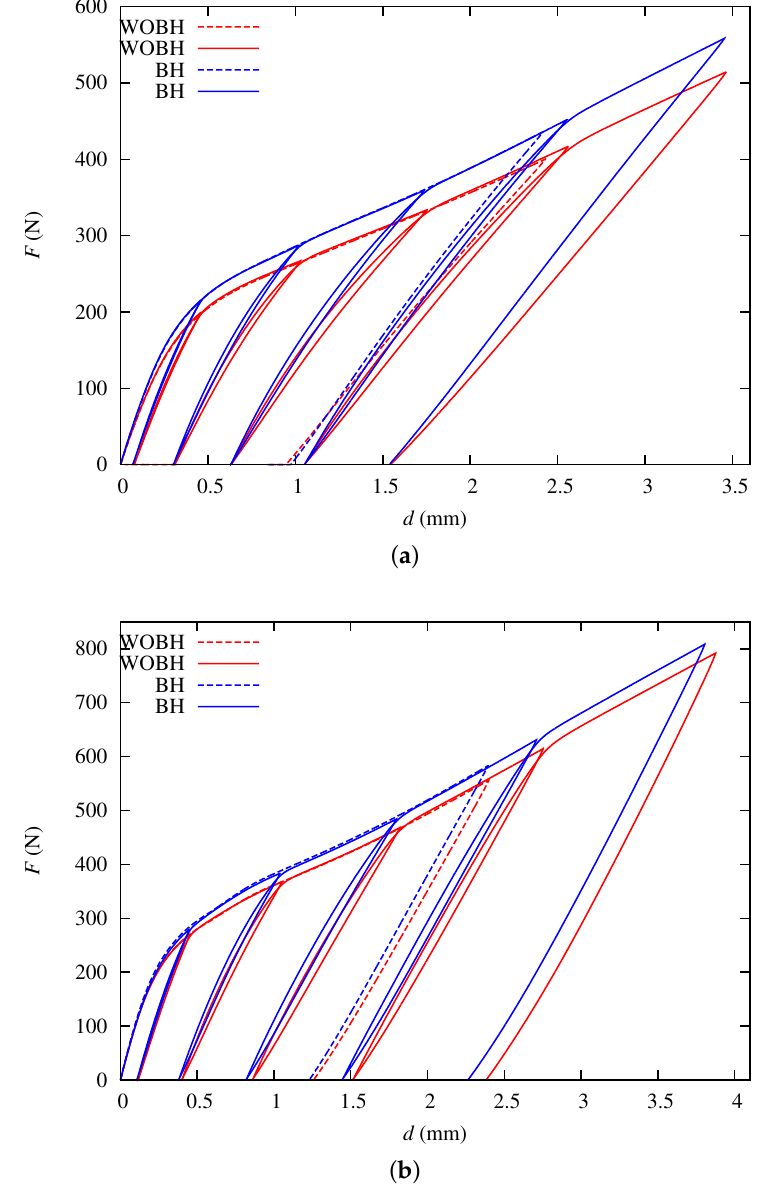
Figure 9. Dent test with (BH) or without bake hardening (WOBH), after a pre-strain in hydraulic bulging. Several loading-unloading-reloading sequences are applied during the tests. Continuous and dashed lines represent two tests having the same pre-strain magnitude. ( a ) Pre-strain (cid:101) xx = 0.02; ( b ) Pre-strain (cid:101) xx =